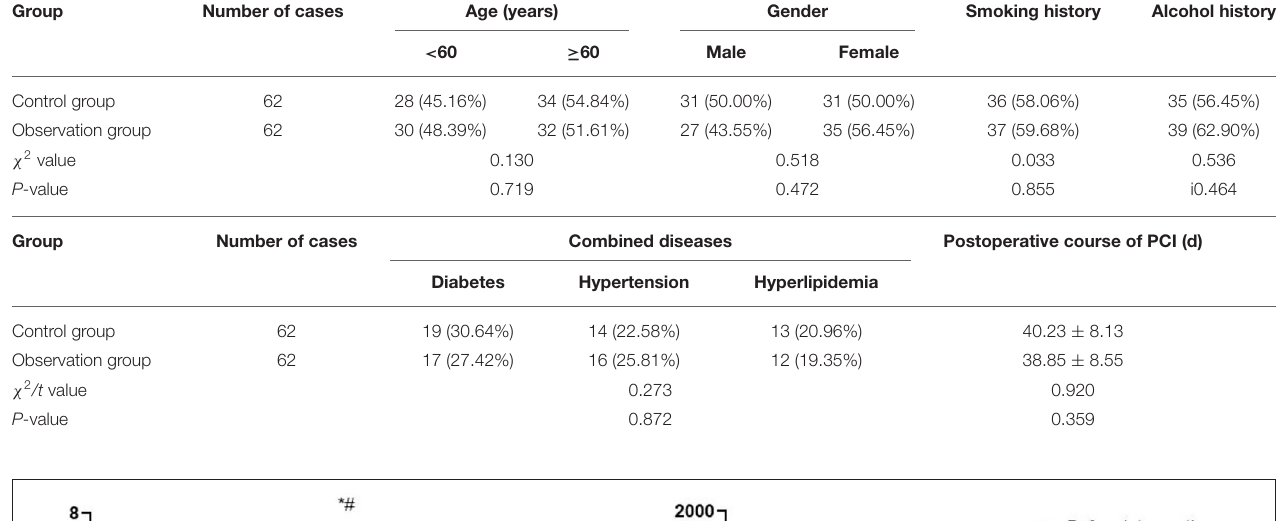
TABLE 1 | Baseline information of patients ( n , %, ¯ x ± s).